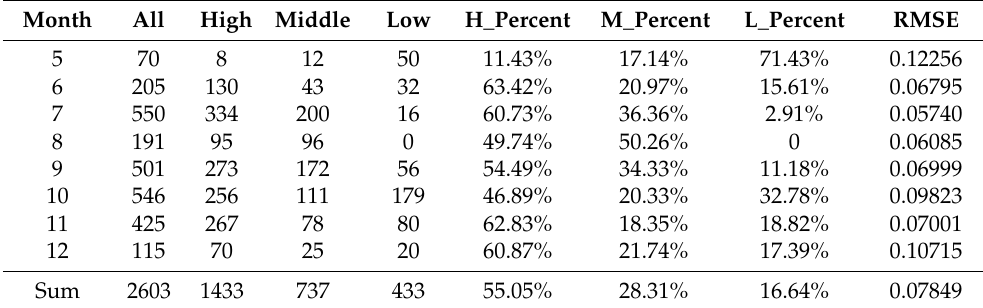
Table 7. Total number of samples; number and proportion of high-, middle-, and low-prediction- quality samples; and RMSE for each month of the test datasets are recorded in this table.